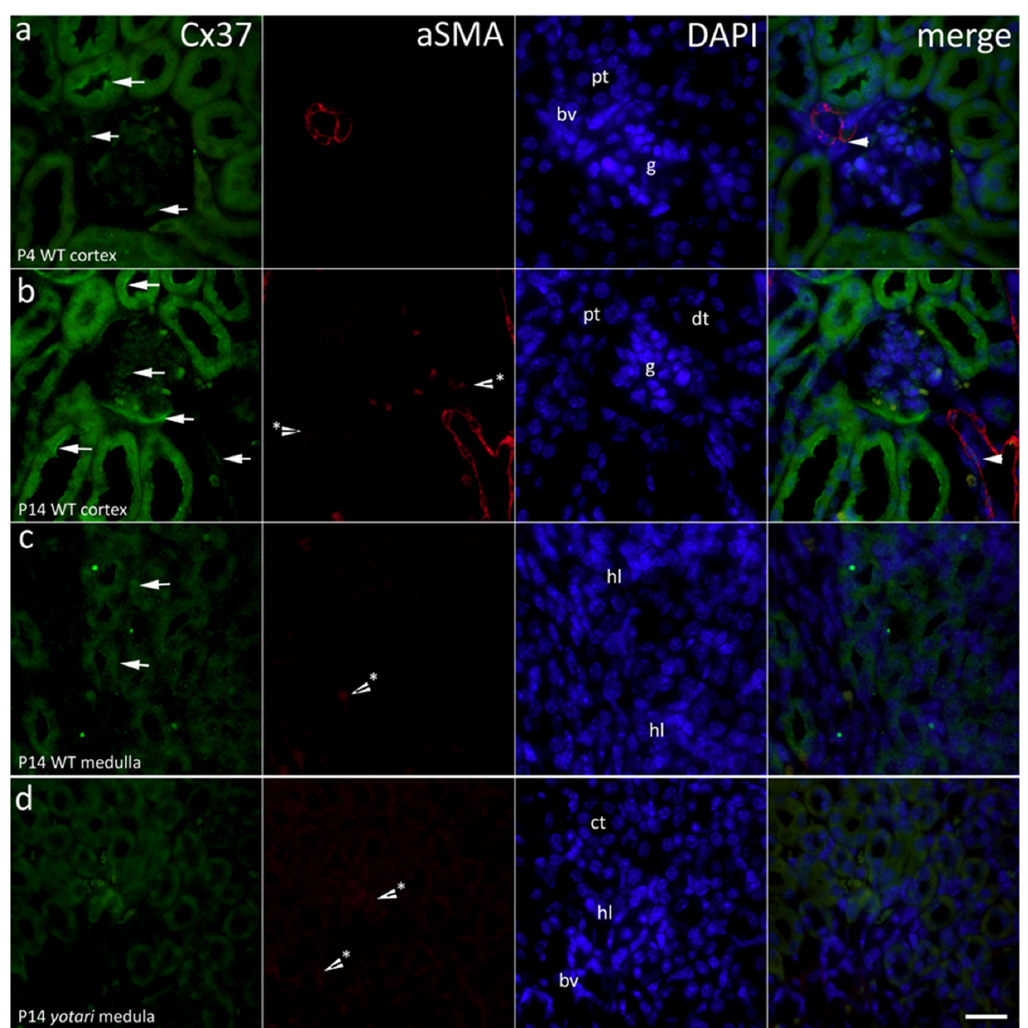
Figure 1. Immunofluorescence staining of postnatal yotari ( d ) and wild type ( a , b , c ) mouse kidneys with the Cx37 marker and co-expression of Cx37 and aSMA with DAPI nuclear staining. Expression of Cx37 (arrows), collecting tubules (ct), blood vessels (bv), glomeruli (g), loop of henle (hl), proximal convoluted (pt), and distal convoluted tubules (dt). Co-expression of Cx37 and aSMA (arrowheads) can be seen on merged photographs. Autofluorescence of nephron tubules and erythrocytes (*), not to be mistaken with positive immunofluorescence staining. Scale bar is 20 μ m, refers to all images.